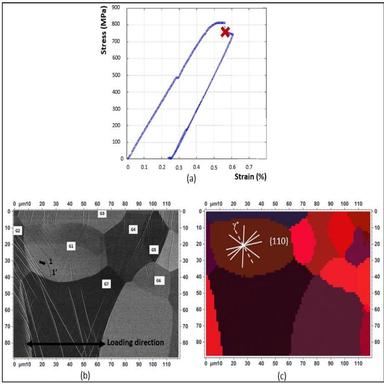
Determination of the experimental plane trace family. (a) Stress/strain tensile curve with loading/unloading parts (b) ECCI micrograph of the analyzed zone showing the slip trace segments and from grain G1. (c) Theoretical slip plane traces of associated to G1 crystallographic orientation.